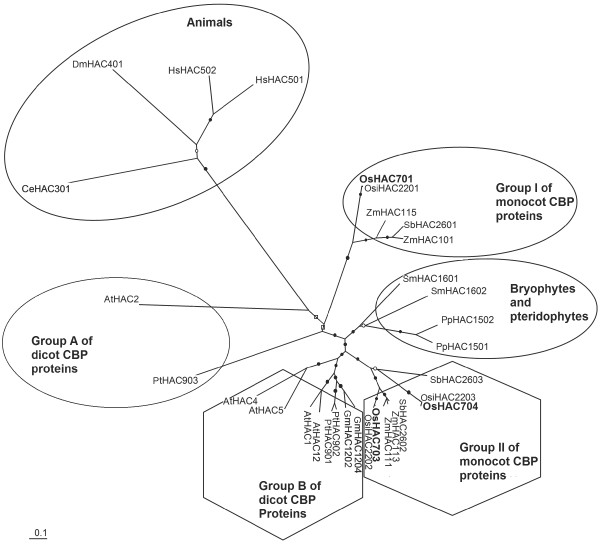
Phylogenetic analysis of CBP family proteins from different plant and animal species. An unrooted tree was constructed using the neighbor-joining distance method with the PHYLIP package. Bootstrap support values (1–1000) for individual branches are indicated as: excellent support (bootstrap value ≥ 995; filled circle); strong support (bootstrap value > 910; empty circle); and good support (bootstrap value = 660; empty square).